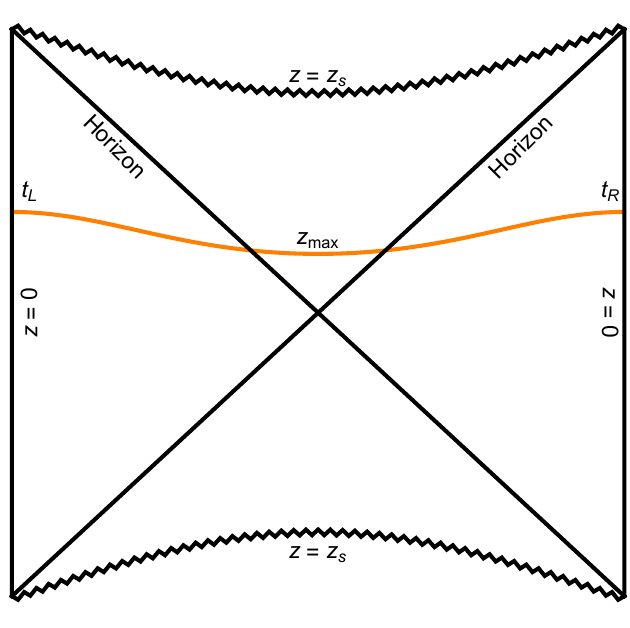
(cid:16) (cid:17) 1 /d 1 − 1 z h 4 λ GB